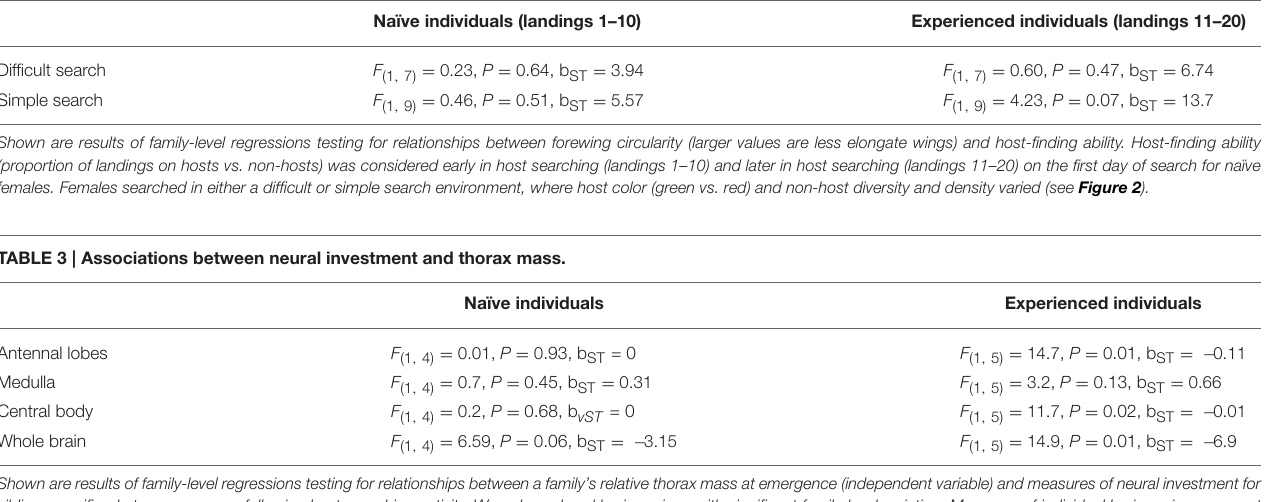
TABLE 2 | Associations between forewing circularity and host-finding efficiency. Naïve individuals (landings 1–10)